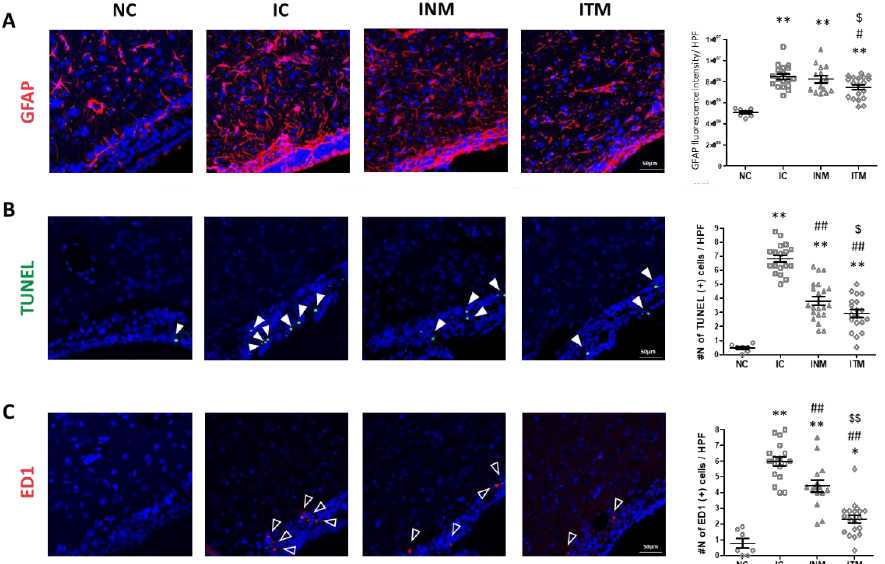
Figure 3. Decreases in reactive gliosis, activated microglia, and cell death induced by severe IVH after treatment with thrombin-preconditioned MSCs. Immunofluorescence micrographs and quantified averages of the ventricular area with ( A ) GFAP (red), ( B ) TUNEL (green), and ( C ) ED-1 (red) staining. The nucleus was visualized with DAPI (blue) (original magnification, ×200). ( n = 7, 18, 15 and 19 in the NC group, IC group, INM group and ITM group, respectively.) Data are expressed as means ± SEM. * p < 0.05 and ** p < 0.01 compared to the NC group, # p < 0.05 and ## p < 0.01 compared to the IC group, $ p < 0.05 and $$ p < 0.01 compared to the treatment with naïve MSCs group; NC, normal control; IC, IVH control; INM, IVH with transplantation of naïve MSCs; ITM, IVH with transplantation of thrombin-preconditioned MSCs; IVH, intraventricular hemorrhage; MSCs, mesenchymal stem cells; GFAP, glial fibrillary acidic protein; TUNEL, terminal